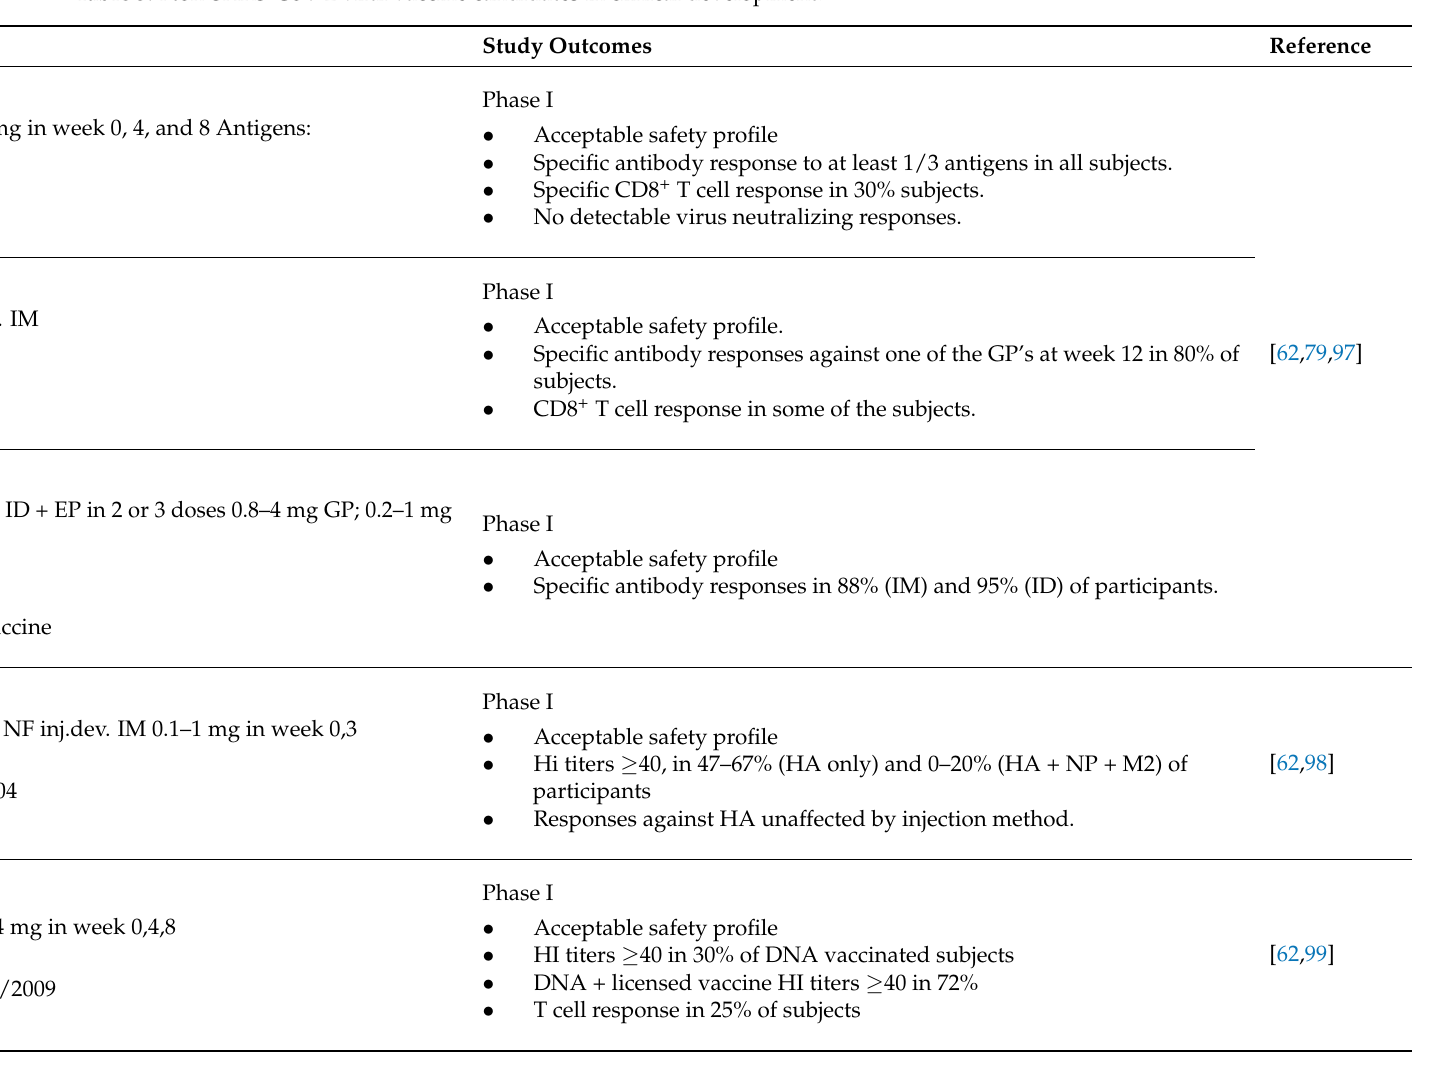
Table 3. Non-SARS-CoV-2 viral vaccine candidates in clinical